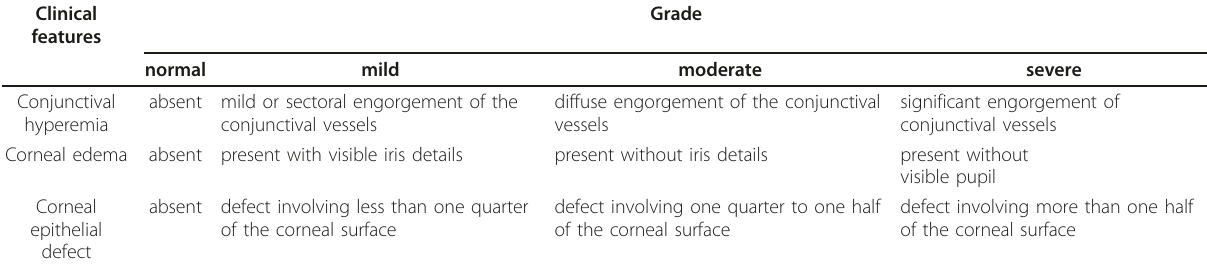
Table 1 Grading of the clinical inflammatory features of alkali chemical injury on cornea [4,18]. Clinical